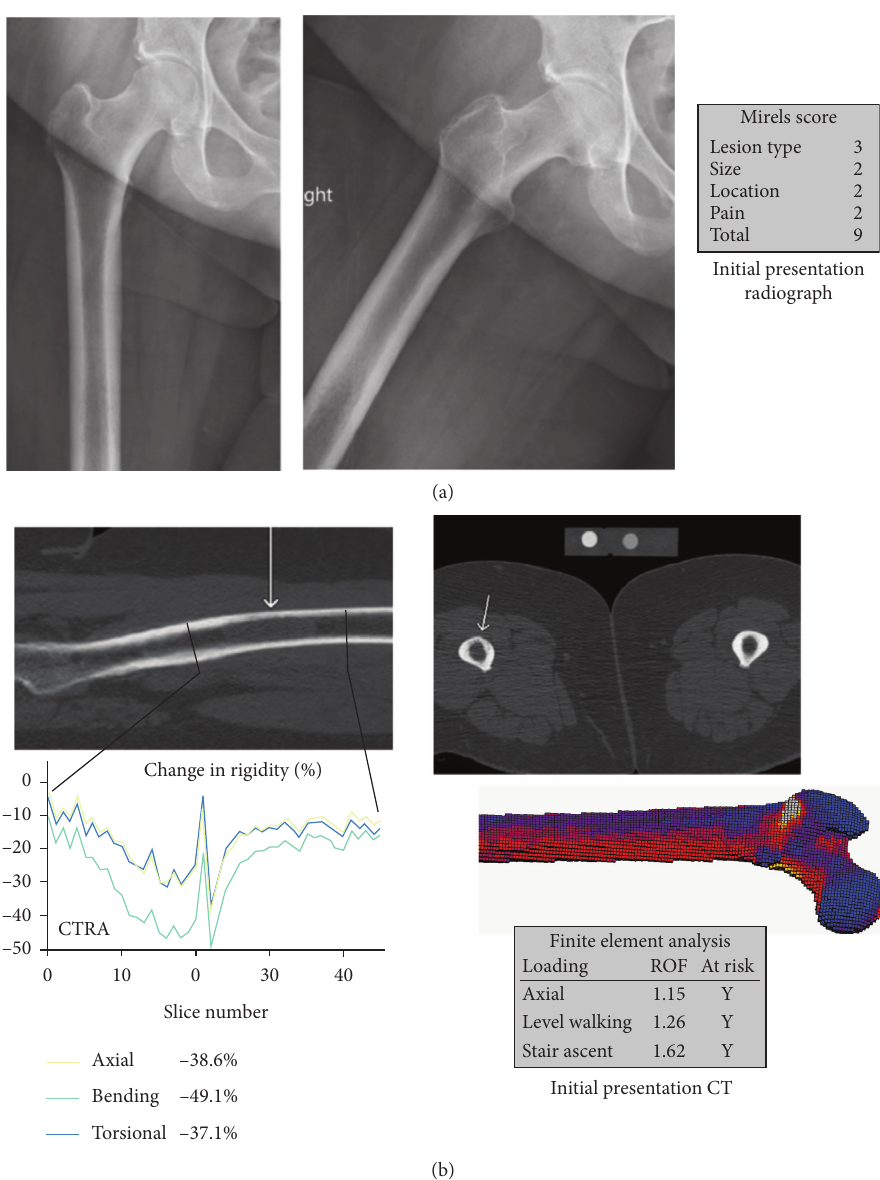
Figure 5: False positive (CTRA+/Fx-) (Case 4, R femur). (a) This is a 68-year-old female with metastatic neuroendocrine carcinoma demonstrating an osteolytic lesion in the right femoral diaphysis. (b) Both CTRA and FEA predicted that the patient would fracture; however, she was treated nonoperatively with EBRT and did not fracture over the course of her one-year